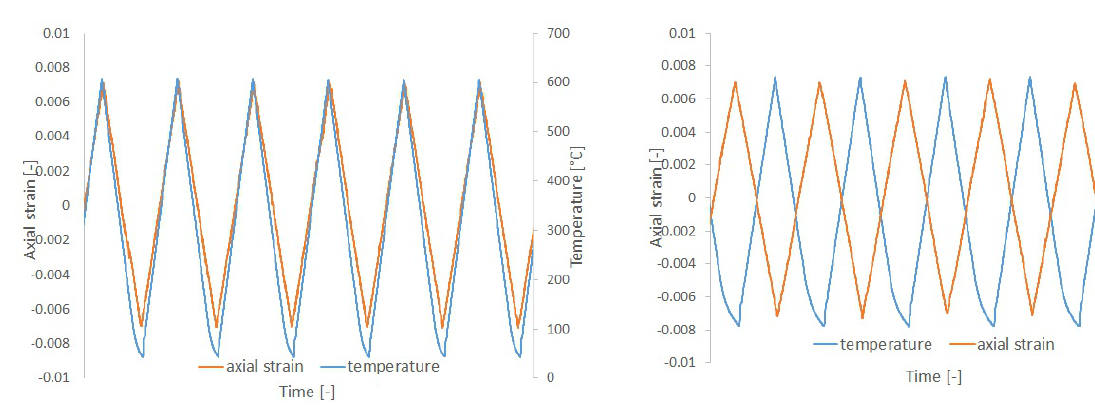
Figure 6. Time dependence of axial strain and tem- perature during the in-phase TMF test.